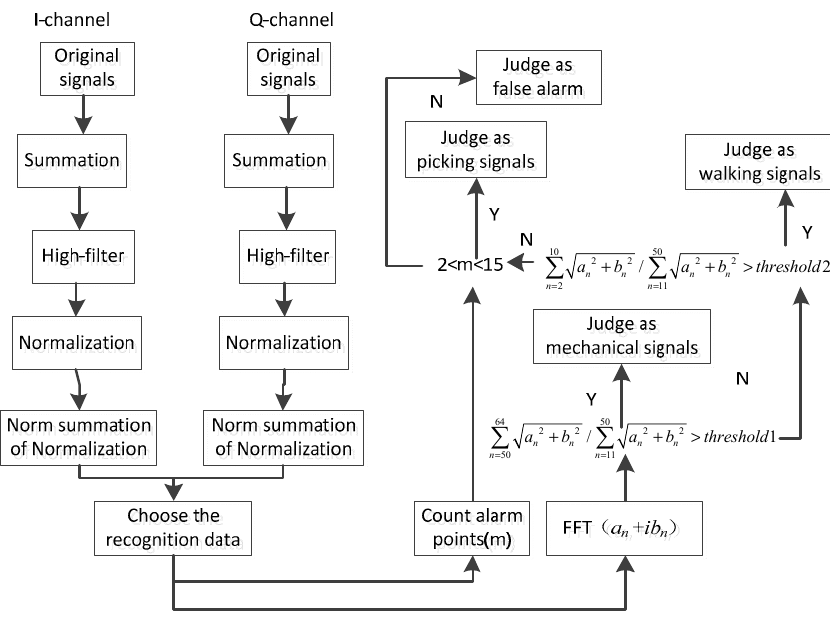
Figure 1. The whole flow of the algorithm.